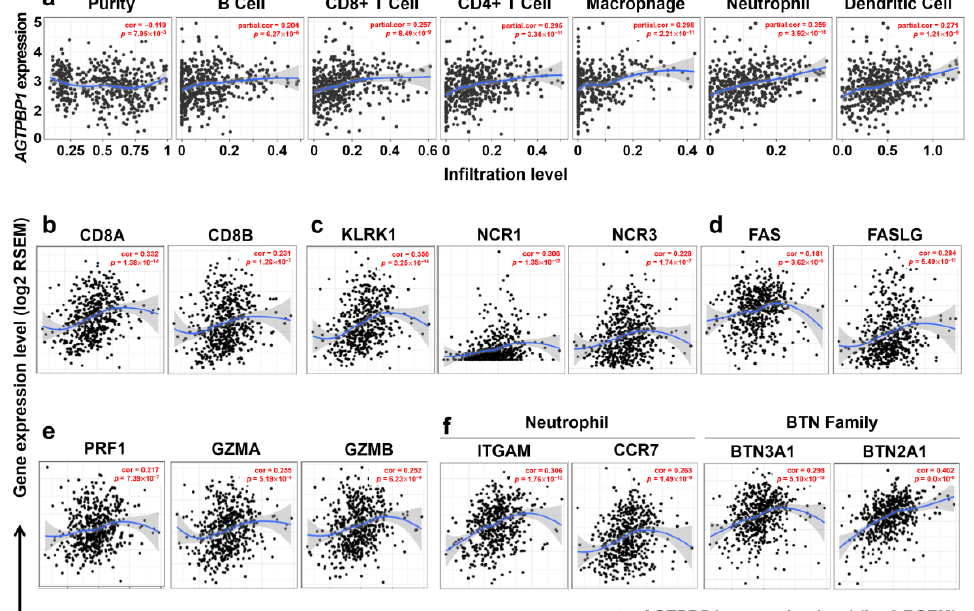
Figure 7. Correlation of ATP / GTP binding protein 1 ( AGTPBP1 ) expression with diverse immune cells and related marker genes in lung adenocarcinoma (LUAD), analyzed using the Tumor